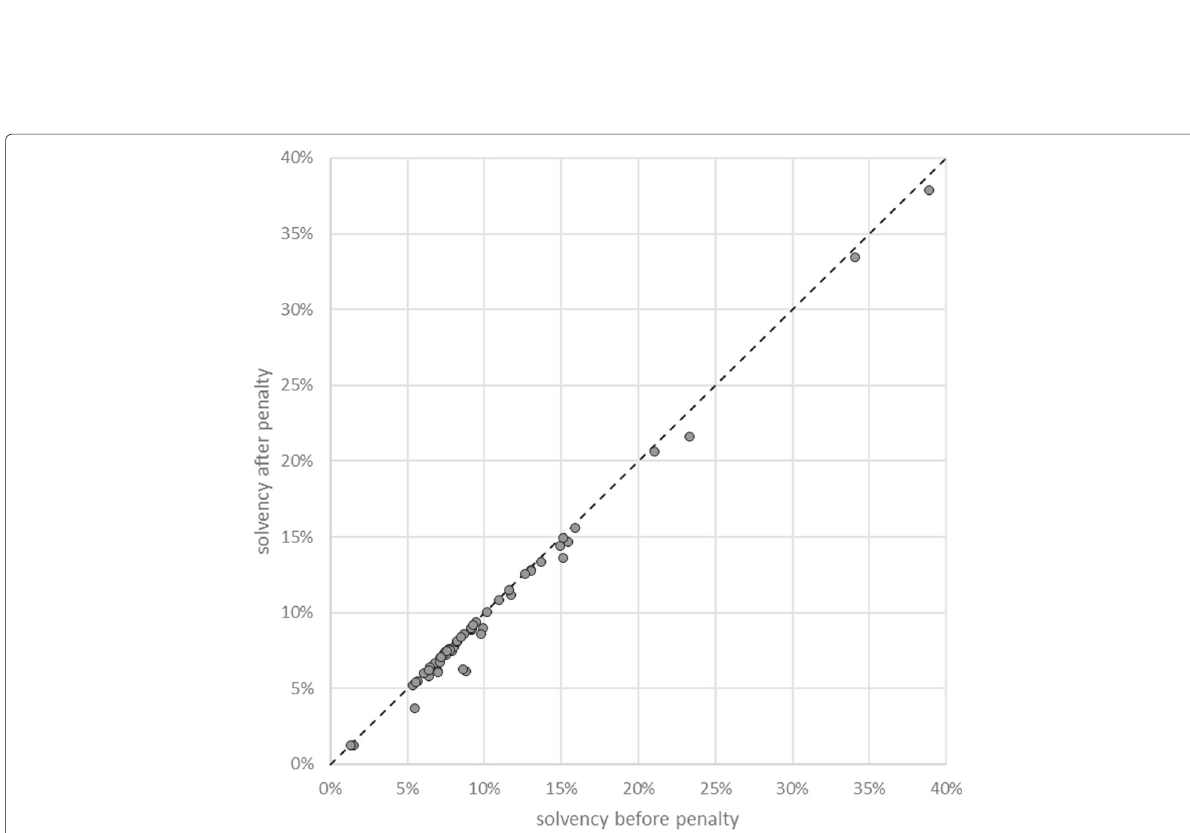
Fig. 3 The penalties had a minimal effect on the solvency of most banks. Solvency is measured as capital divided by the size of the balance sheet. “Before penalty” means the balance sheet data of the bank as reported in the 2013 end of year annual report. “After penalty” subtracts the penalty (in CHF, using the end of year exchange rate of 1 USD = 0.8929 CHF) from capital, and divides again by the balance